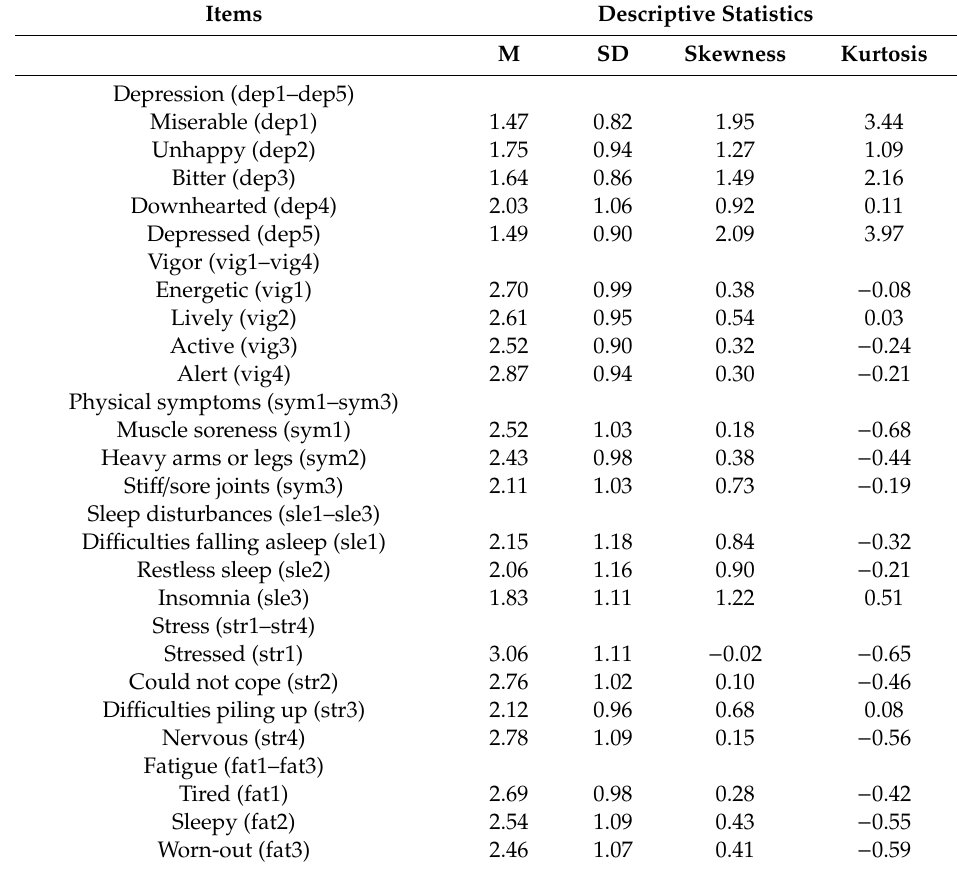
Table 3. Descriptive statistics for 632 participants on the items of